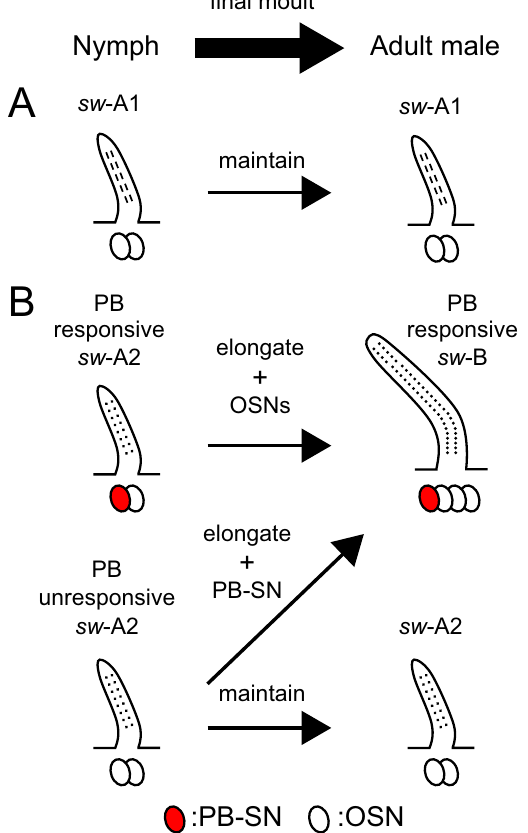
Figure 6. Leading models of the postembryonic developments of olfactory sensilla. ( A ) Schematic drawing of the postembryonic development of sw -A1 sensilla. Anatomical and physiological features indicate that nymphal sw -A1 sensilla are maintained during the postembryonic development of the cockroach. ( B ) Schematic drawing of the postembryonic development of sex pheromone-responsive sensilla. In this study, we obtained following results. (1) Both nymphal sw -A2 and adult sw -B sensilla have common shapes of olfactory pores. (2) All recorded nymphal sw -A2 sensilla have two OSNs, and there are PB-responsive and PB-unresponsive sw - A2 sensilla in nymphs. It has been known that each sw -B sensillum has one PB-SN and three other OSNs 17,19 . Furthermore, a large majority of nymphal sw -A sensilla transform to the sw -B sensilla at the final moult, and the morphogenesis is accompanied the increase of the number of OSNs 28 . Taken together current and previous results, we hypothesized developmental schemes of the sex pheromone-responsive